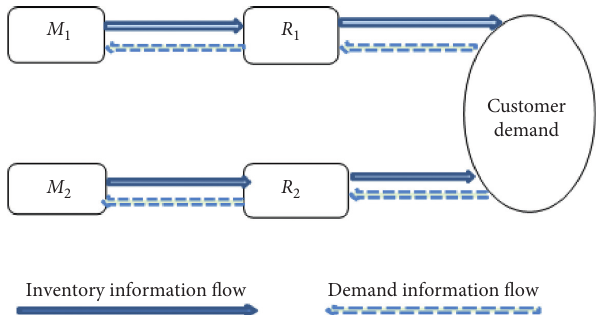
Figure 1: The theoretical model of the two parallel supply